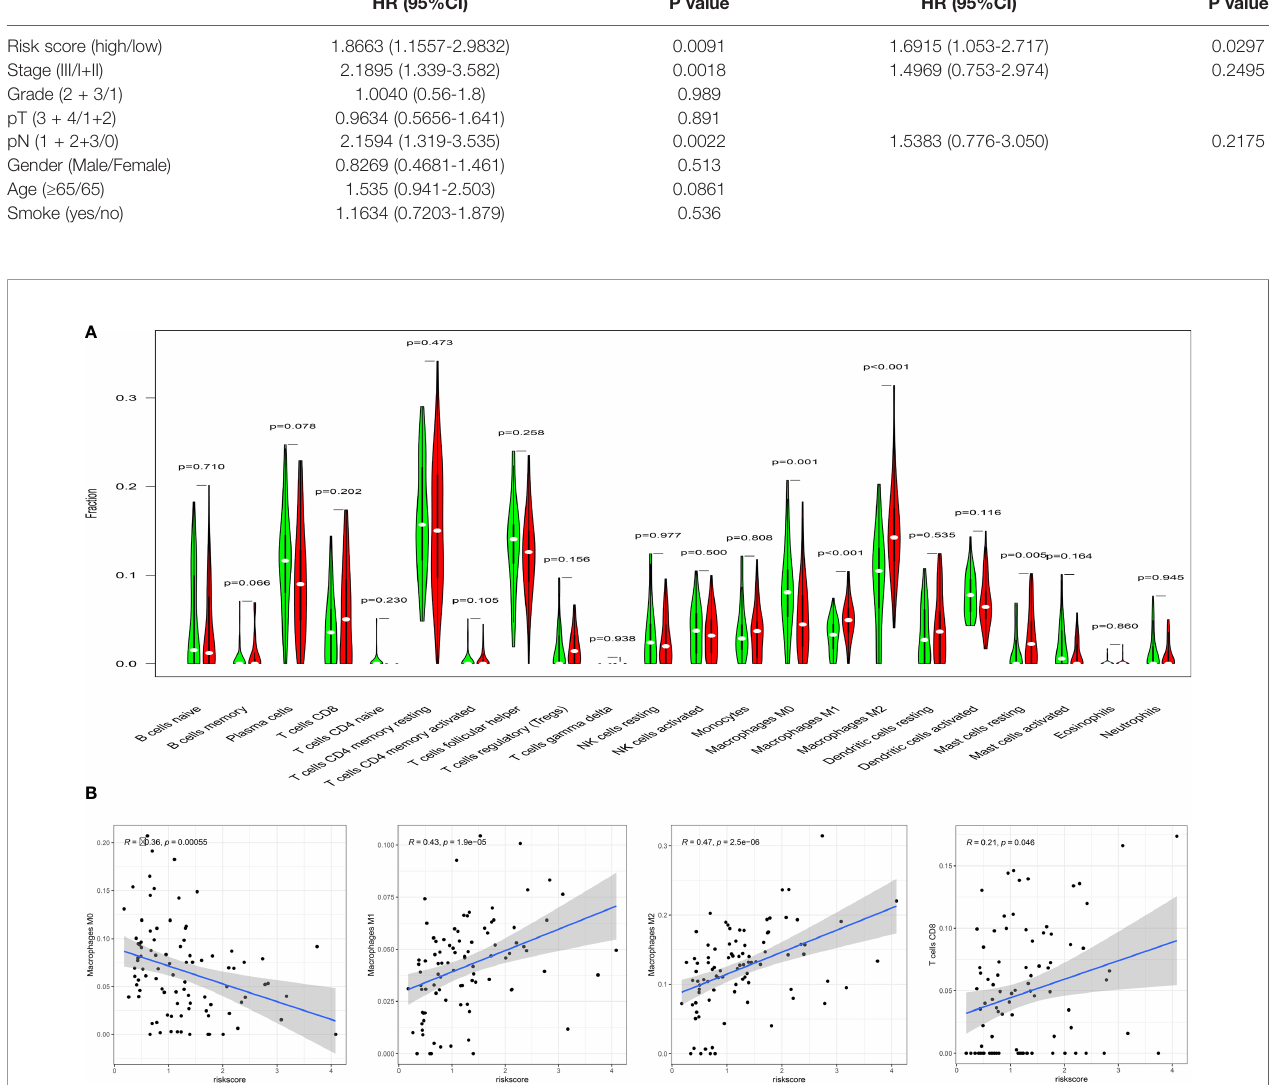
FIGURE 7 | Correlation of TICs with risk score model. (A) Violin diagram for the levels of immune cells between high-risk group(red) and low-risk group (green). (B) There were signi fi cant correlations between risk score model and macrophage M0,M1,M2 and T cells CD8. Pearson test was used for the correlation test